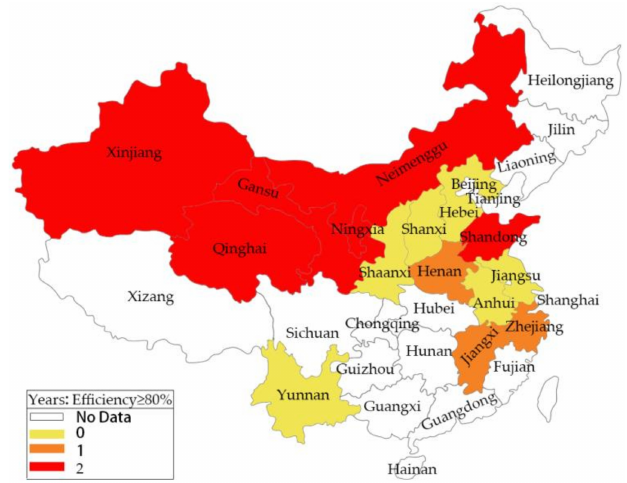
Figure 5. Distribution map of high power generation